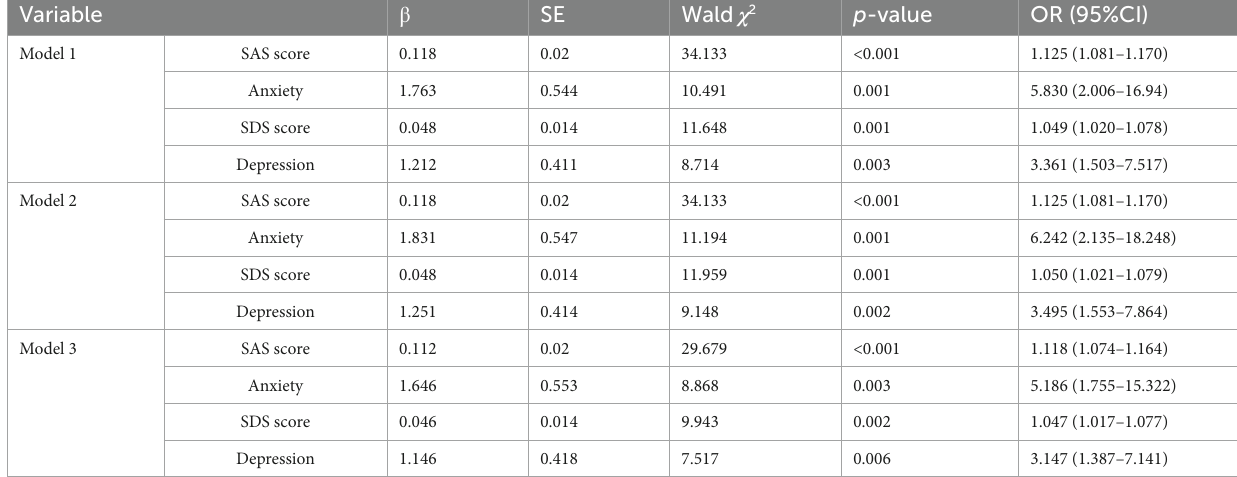
TABLE 2 Multivariate logistic regression analysis of anxiety and depression on migraine.